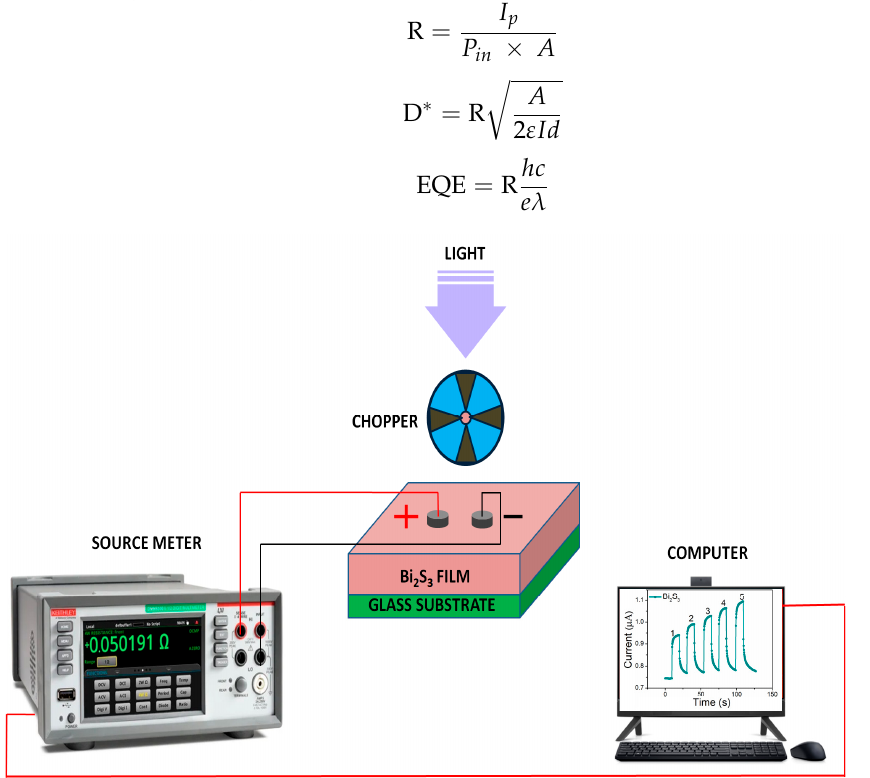
Figure 6. The schematic depiction of the fabricated UV photosensor.